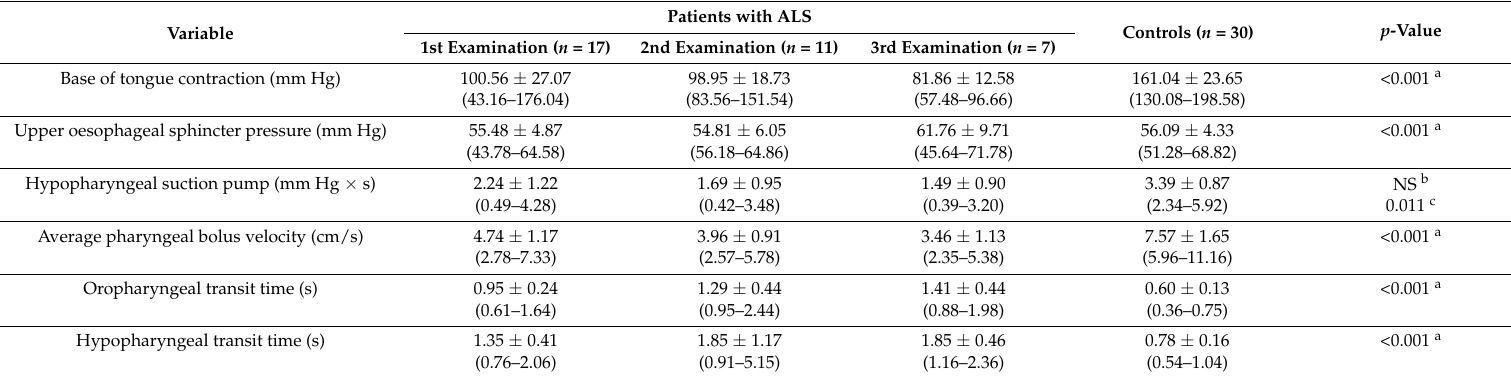
Table 1. Comparison of manometric parameters between patients with amyotrophic lateral sclerosis (ALS) (examinations I–III) and controls during dry swallowing (data are presented as means, standard deviations and ranges).